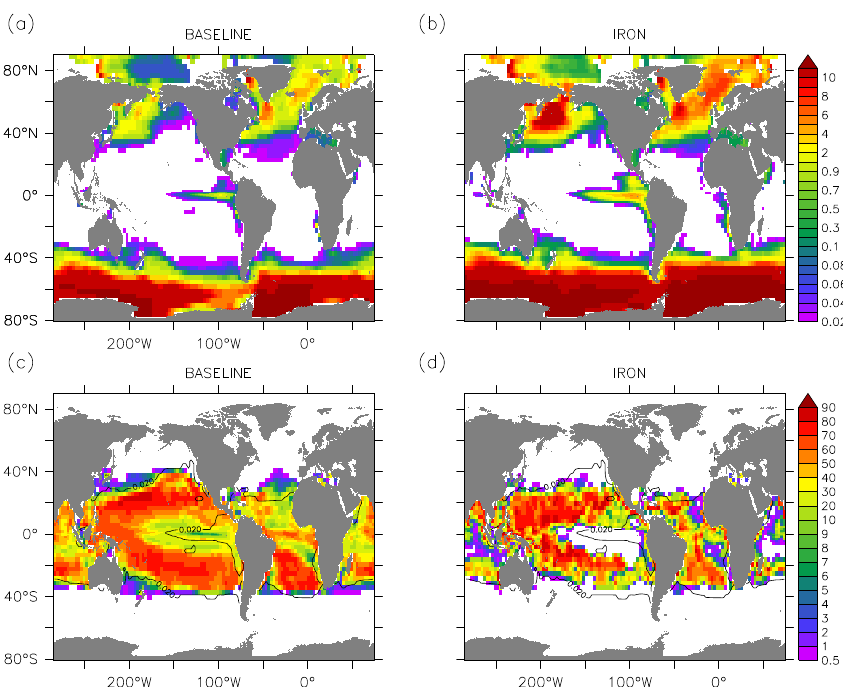
Fig. 3. Average NO − concentrations (mmolm − 3 ) in the upper 50m for (a) BASELINE and (b) IRON simulations. Contribution of di- 3 azotrophs to total autotrophic production (%) in (c) BASELINE and (d) IRON simulations. Black contour represents the sea-surface 0 . 02mmol NO − m − 3 isoline. Figure shows averages over 150 model years. 3